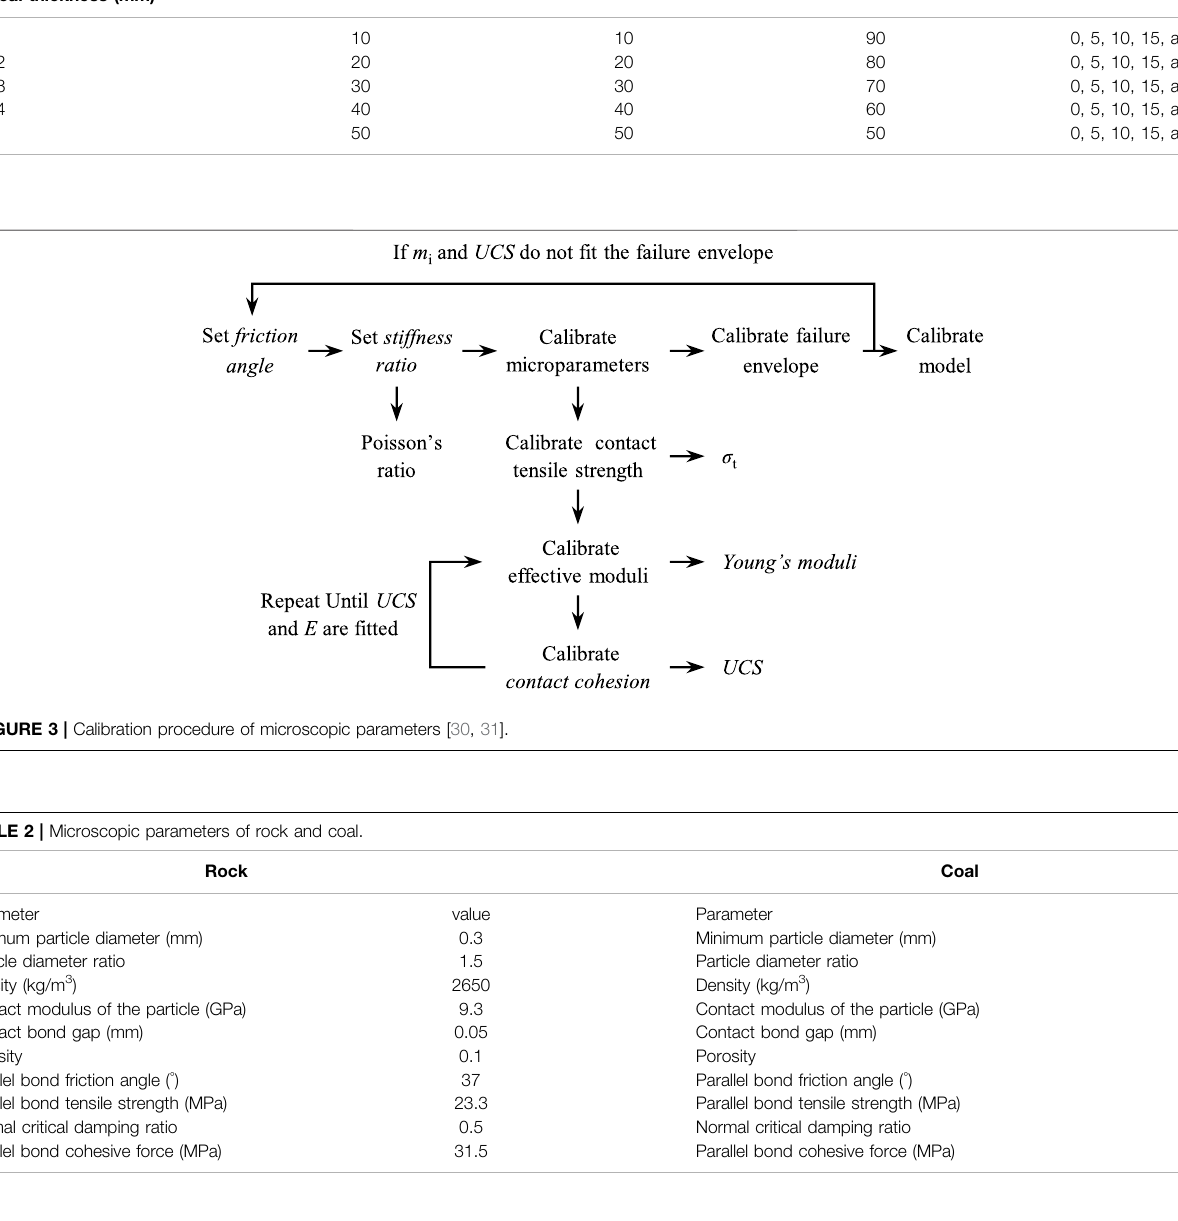
TABLE 3 | The comparison between the experimental and numerical simulation results of the mechanical parameters of coal and rock. Mechanical